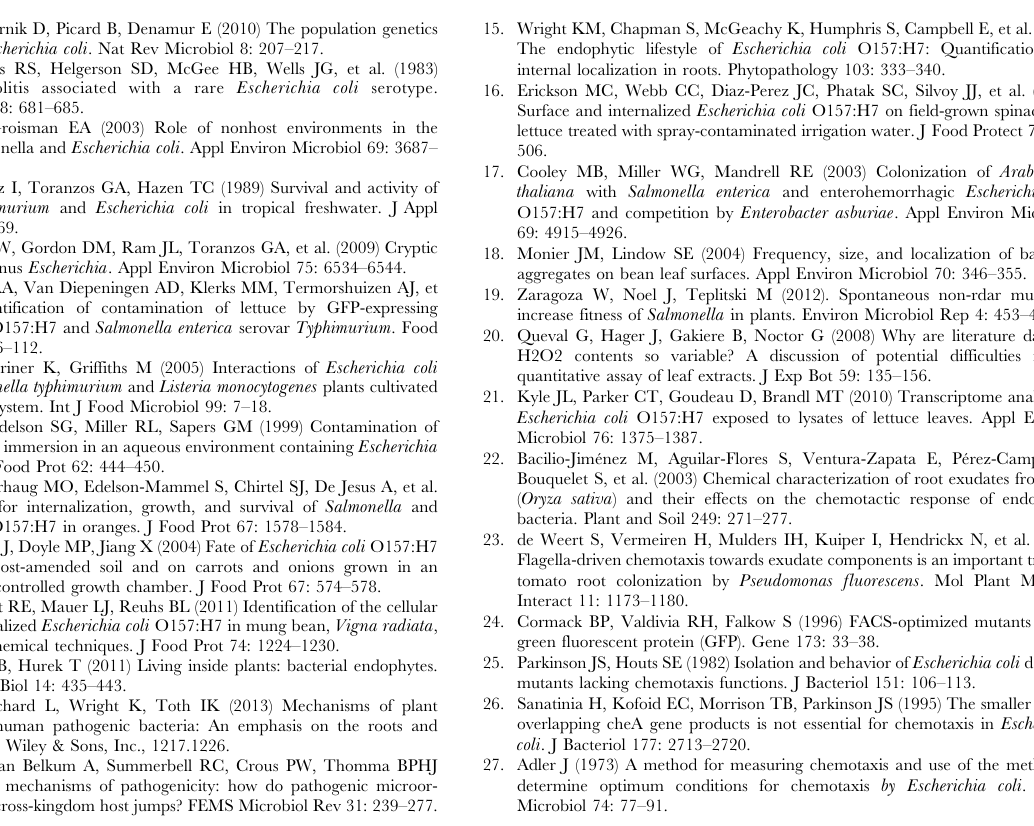
Figure S4 Effect of initial E. coli K12 inoculum size and time course of colonization of lettuce leaves. (A) Assays were run according to the standardized conditions at 20 days after inoculation (see materials and methods) except that the initial dose varied from 10 to 10 8 cells 6 mL 2 1 of agarized medium. Data represent the mean and SD of 3 independent assays comprising a pool of all leaves from three seedlings from each assay. (B) Assays were run according to the standardized conditions (see materials and methods) except that data were separately collected for leaves (empty bars) or roots (full bars) at different times after inoculation. Data represent the mean and SD of 3 independent